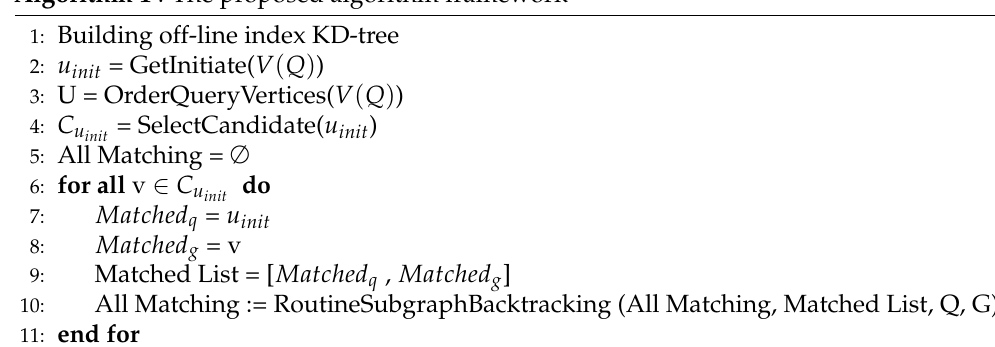
Figure 4. A query multigraph Q2. Algorithm 1 : The proposed algorithm